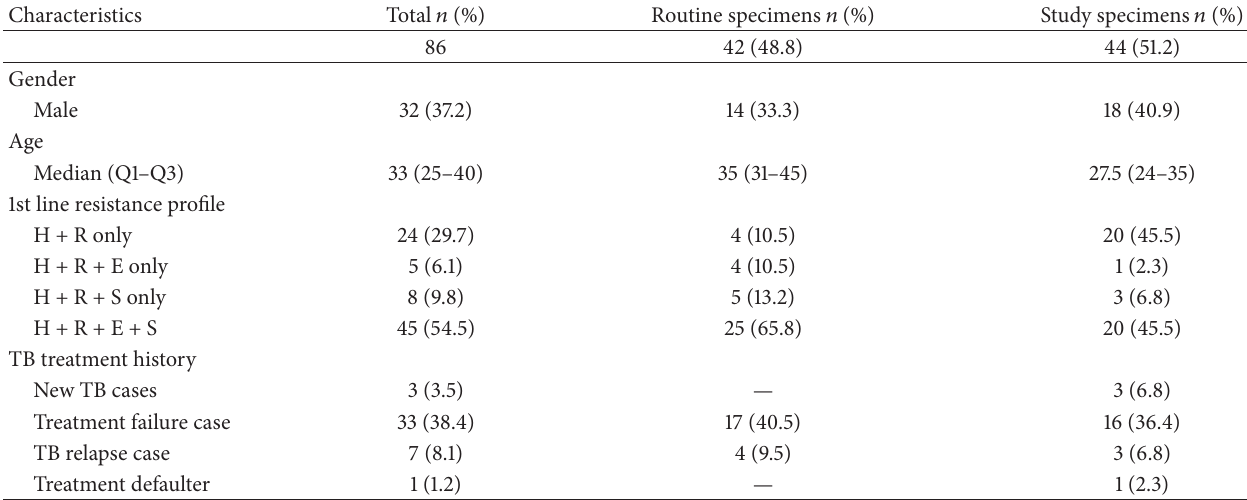
Table 1: MDR patient